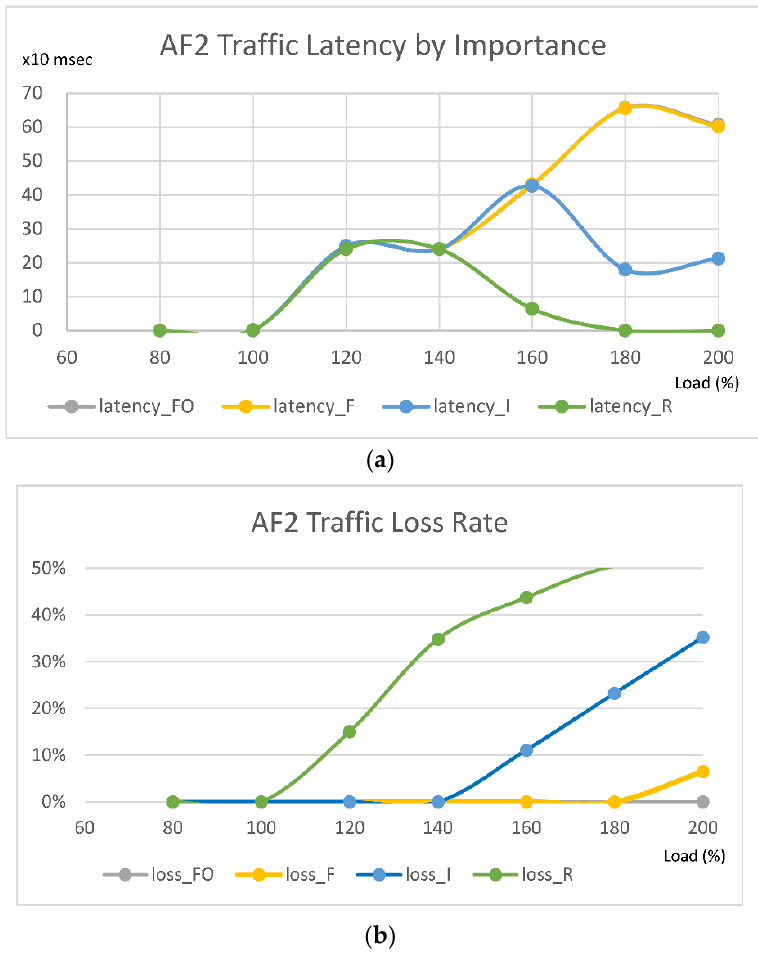
Figure 6. Performance results by importance of the AF2 traffic: ( a ) Latency performance by importance level of the AF2 traffic; ( b ) Loss performance by importance level of the AF2 traffic.